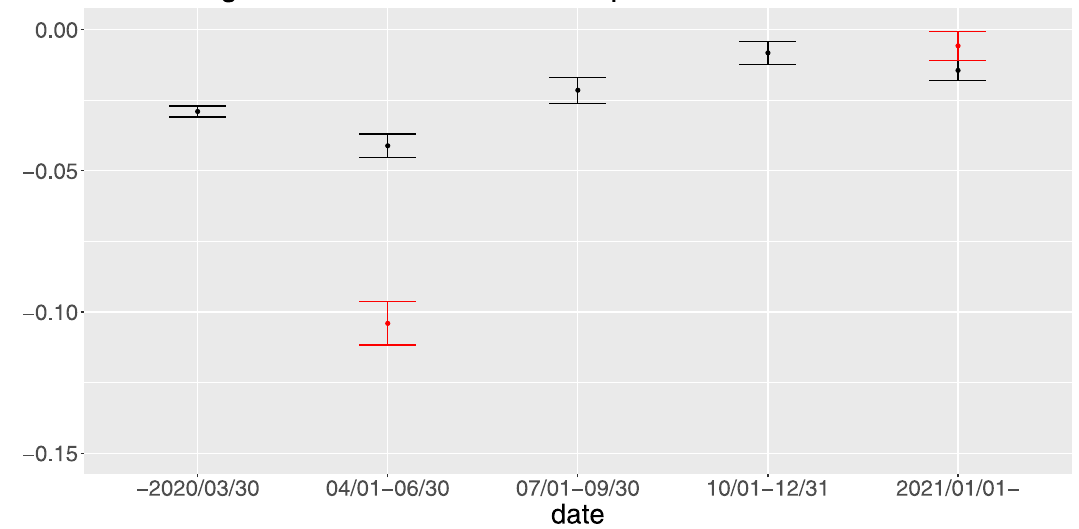
Fig 10. Total marginal effects divided into five periods. We also calculate total marginal effect as for IFC , LD 1, and LD 2 by Eq